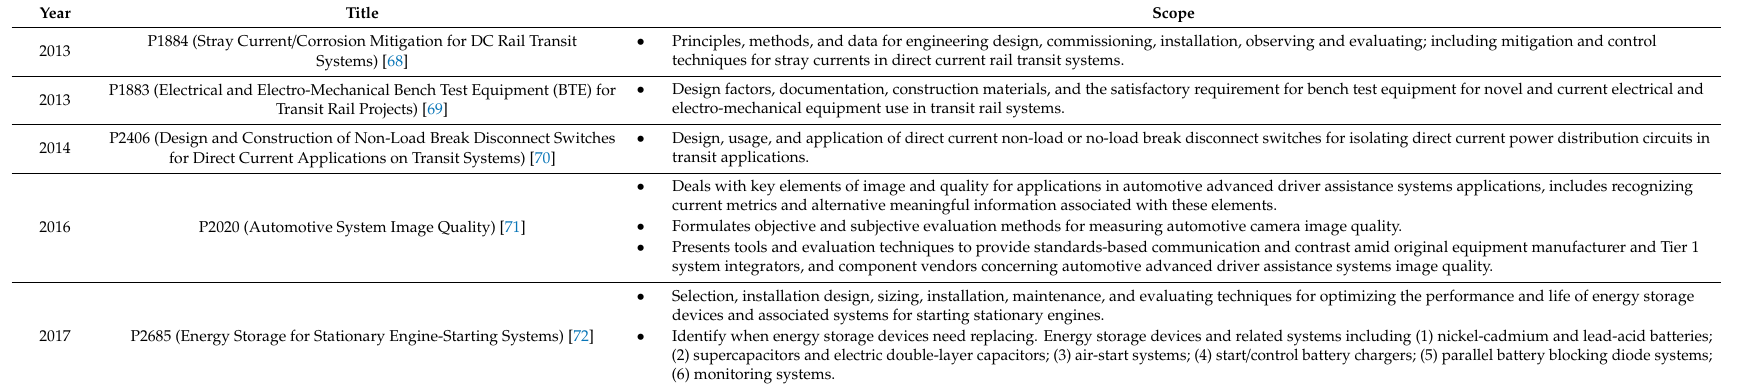
Table 3. Recent IEEE Standards in development for smart mobility and